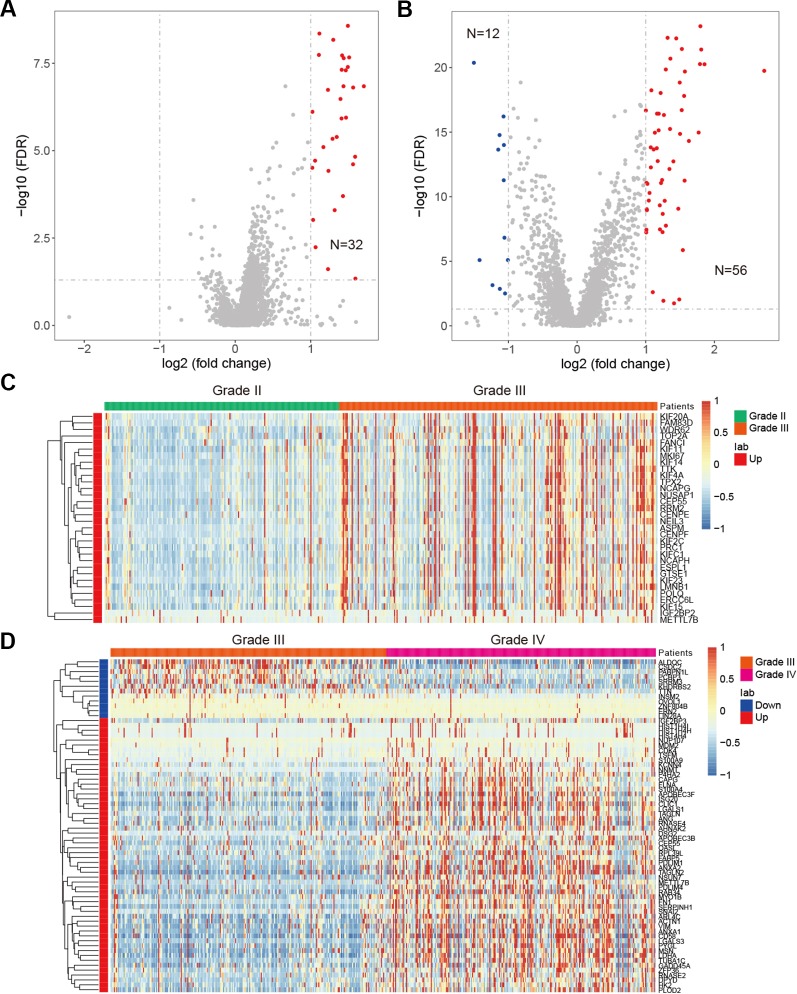
Differentially expressed genes in glioma. (A) Volcano plot shows the differentially expressed genes between grade II and III. Red for up-regulated genes. (B) Volcano plot shows the differentially expressed genes between grade III and IV. Red for up-regulated genes and blue for down-regulated genes. (C) Heat map for genes that perturbed between grade II and III. (D) Heat map for genes that perturbed between grade III and IV.